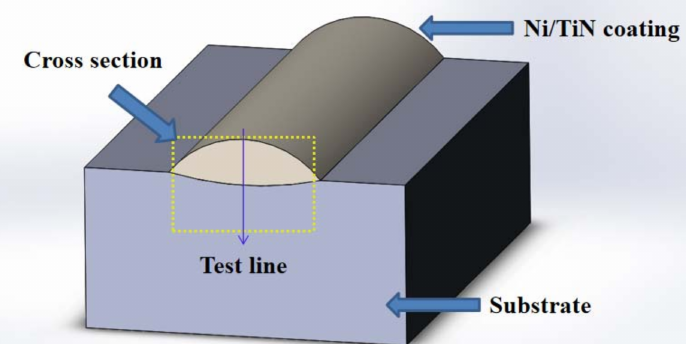
Figure 2. Sampling position for testing the microhardness of Ni/TiN